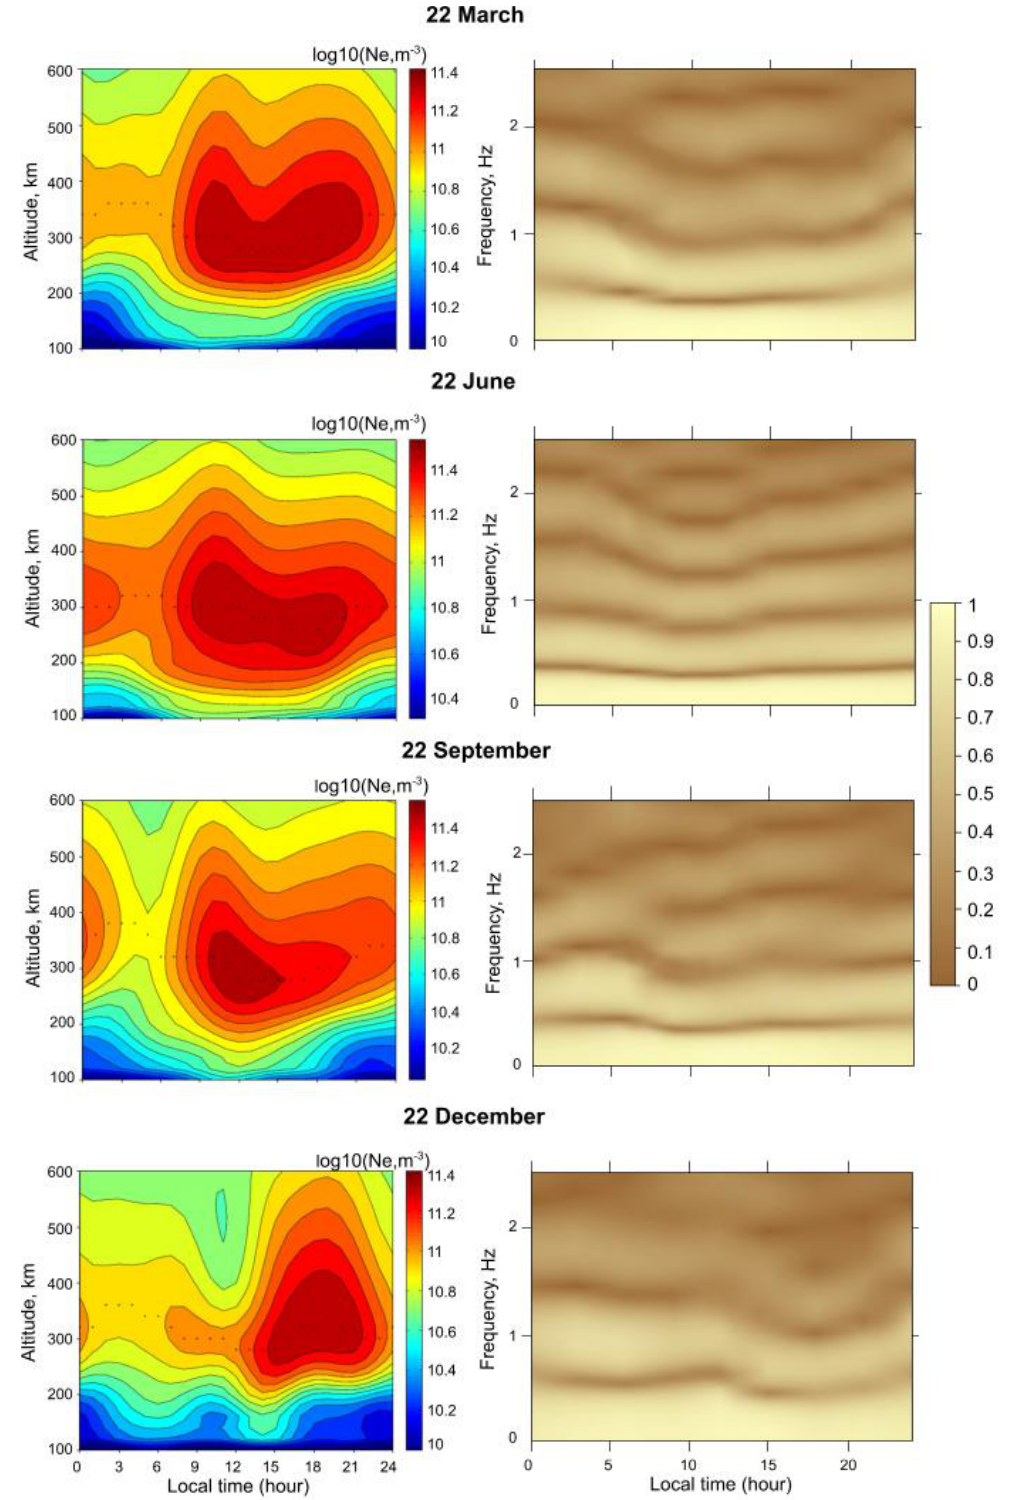
Fig. 5. On the left: Model representation of the diurnal variations of the electron density versus height above Svalbard. On the right: Diurnal variations of the ionospheric reflection coefficient calculated on the basis of the IAR theory, taking account of the electron density